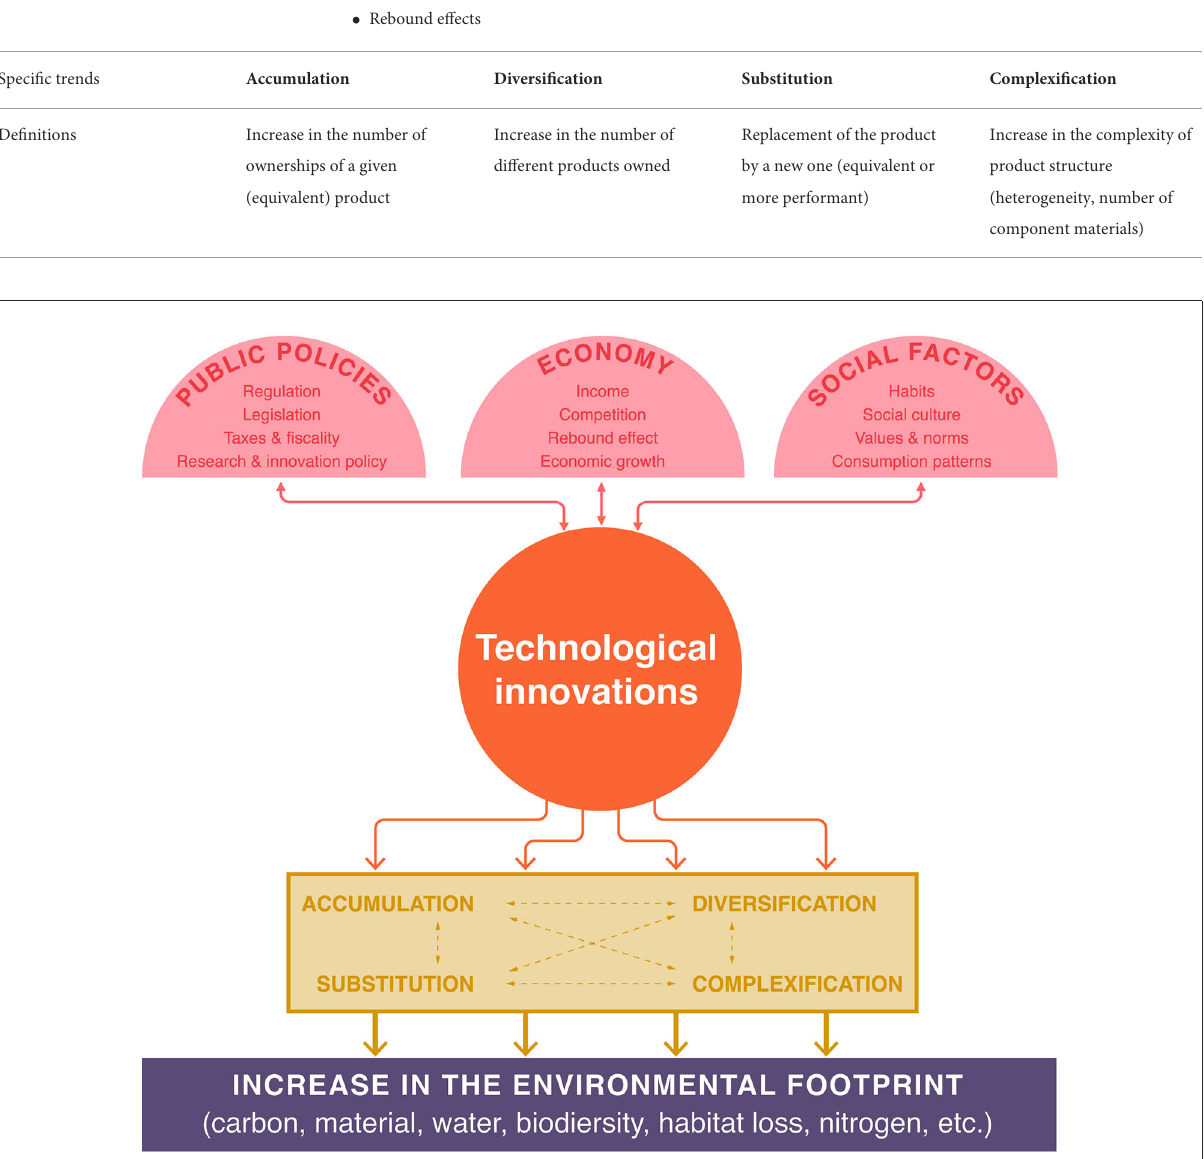
FIGURE1 Rationalization of some trends associated with technological innovations and their societal drivers (public policies, economy, and social factors). In return, technological innovations play the role of the driver by influencing the economy, public policies, and social behaviors. The four trends identified are also interdependent as indicated by double-headed dotted line